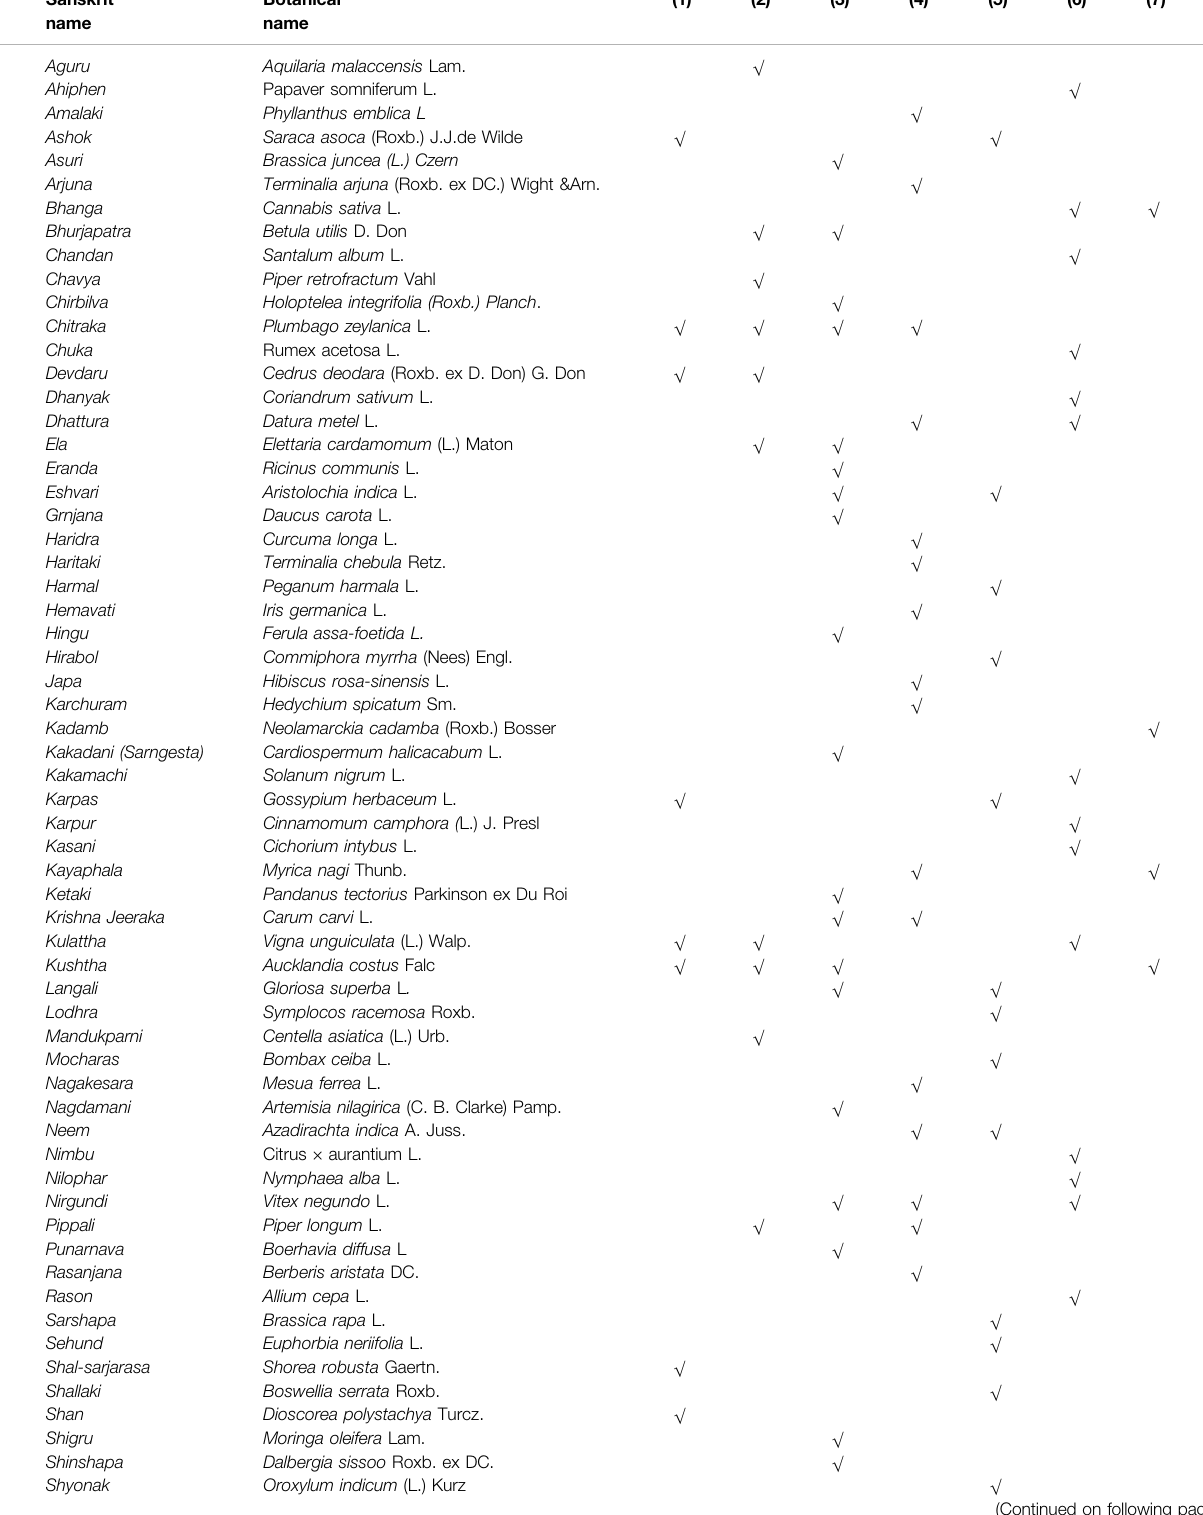
TABLE 1 | List of plant and metal drugs as contraceptives in Ayurveda classics. Vertical column numbers indicate AaartavJanan — Emmenagogue (1), Aparapatan — placental expulsion (2), Garbhanuloman/Garbhapatkar — Abortifacient or Garbhastravakar — expel Fetus (3), Garbhanirodhak Contraceptives (4), Garbhashayasancochak — Ecbolic(5), Shandhyakar/Pumstvopadhatin — drugsthathampermale sexual orreproductivecapability(6),and Shukrashodhan — Depurates (7). Sr.